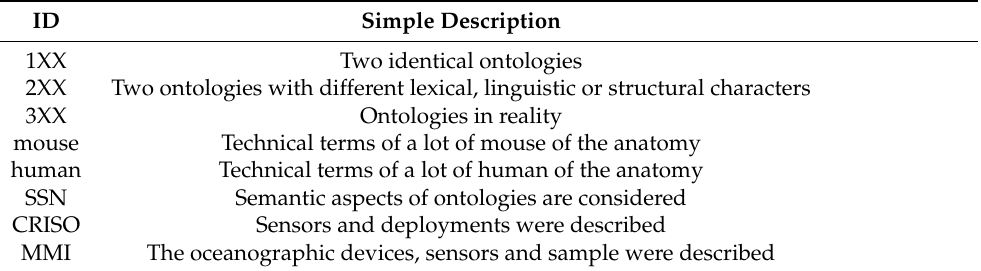
Table 8. A Brief Description On Testing Data Sets.